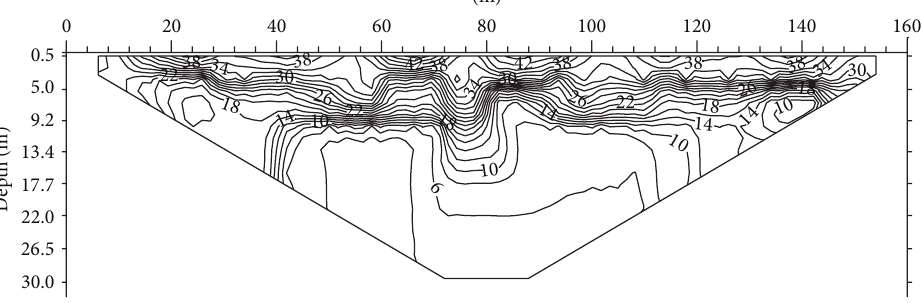
Figure 9: Investigation of 2D porosity image of second line.